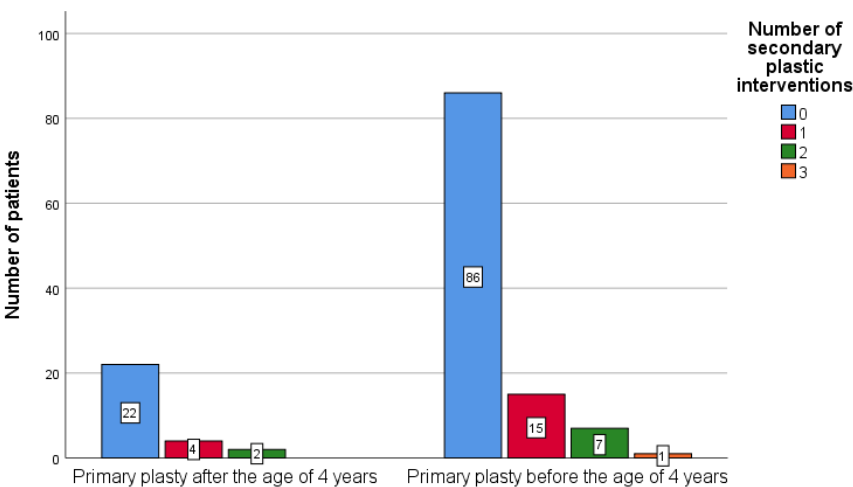
Figure 3. Frequency of secondary palatal surgical interventions in patients younger and older than 4 years. 4 years.